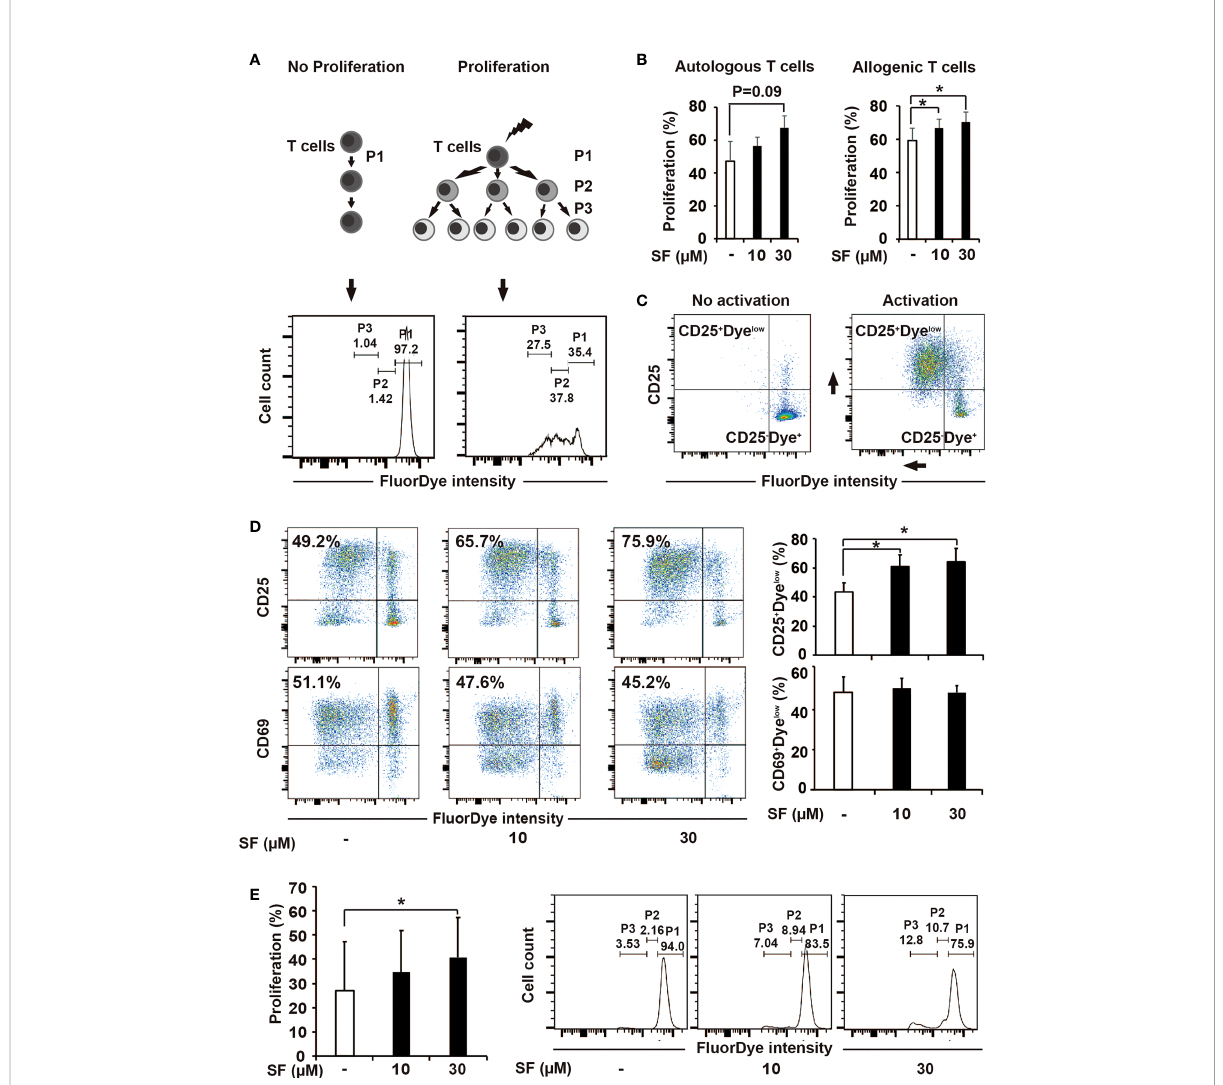
FIGURE 2 Sulforaphane improves stimulatory capacity of dendritic cells (DCs). (A, B) The principle and evaluation of proliferation assay. (A) Difference in the activation ability towards T cells was assessed by the distribution of FluorDye among proliferating cells. The representative histograms show the gating strategy of a non-proliferating (P1) and proliferating T-cell populations (P2 and P3) in negative and positive control. The numbers indicate different percentages of each portion from one representative experiment. (B) Mature monocyte-derived dendritic cells (MoDCs) were treated with sulforaphane (SF) at indicated concentrations or vehicle control for 48 h. The same amount of DCs were co-incubated with autologous or allogenic FluorDye-labeled peripheral blood mononuclear cells (PBMCs) at ration 1:10 for 5 days, with the addition of CD3/CD28 puri fi ed antibodies. The proliferation of T cells was analyzed by fl ow cytometry and FlowJo software. The sum of P2 and P3 percentage was used as a Proliferation percentage (%), n = 4. (C, D) The principle of assessment and evaluation of T-cell late activation marker CD25. (C) The dot plot on the left indicates a non-proliferating T-cell population (negative control), composing to a large extent CD25 - Dye high population. During T-cell activation (positive control), FluorDye distributes among daughter cells leading to the FluorDye signal shift to the left in X-axis, and the CD25 shift in Y-axis, forming CD25 + Dye low population. Representative dot plots are shown. (D) Co-incubation of DCs and PBMCs was performed as in 2B. Cells were labeled with CD25-V450 and CD69-APC-Cy7 antibodies and analyzed by fl ow cytometry and FlowJo software. The data are presented as mean ± SD. Dot plots provide the data from one representative experiment, n = 4. (E) Sulforaphane affects stimulatory capacity of DCs in presence of pancreatic cancer antigens. Tumor lysate was prepared and used to treat MoDCs for 24 h. MoDCs were matured and treated with sulforaphane at indicated concentrations or vehicle control for 48 h. The co- incubation was performed and analyzed as shown in (B) . Representative histograms are shown on the right, n = 4. *P ≤